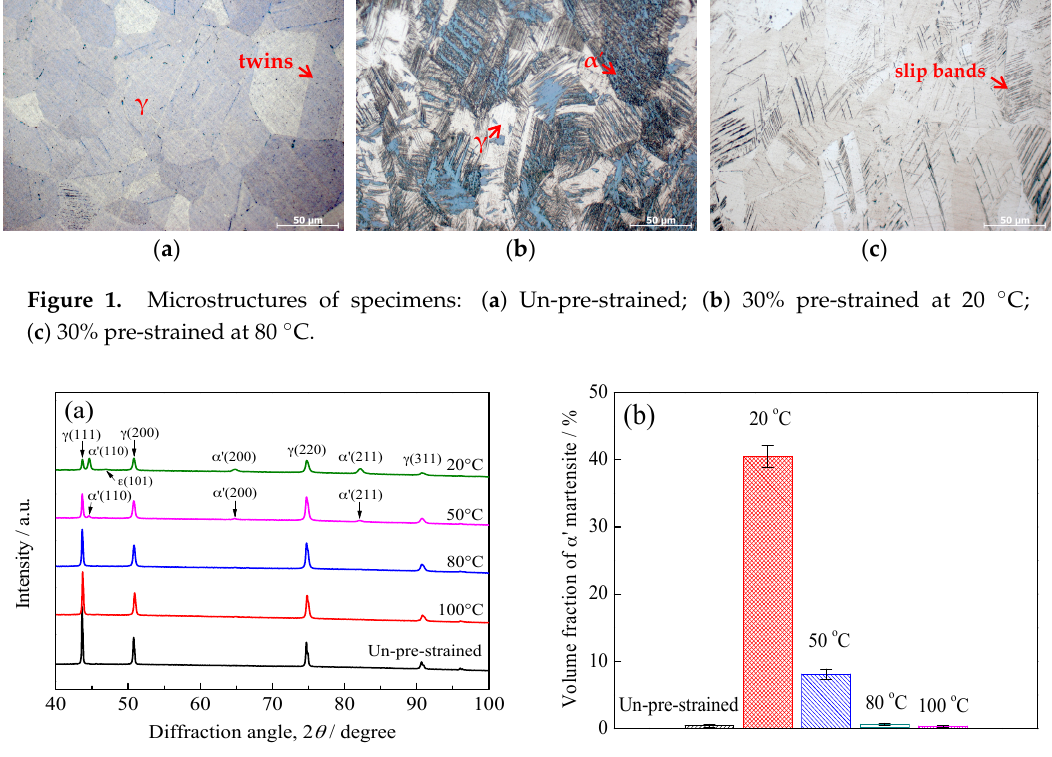
Figure 2. X-ray diffraction (XRD) results of specimens: ( a ) The XRD patterns; ( b ) The volume fraction of α′ martensite.